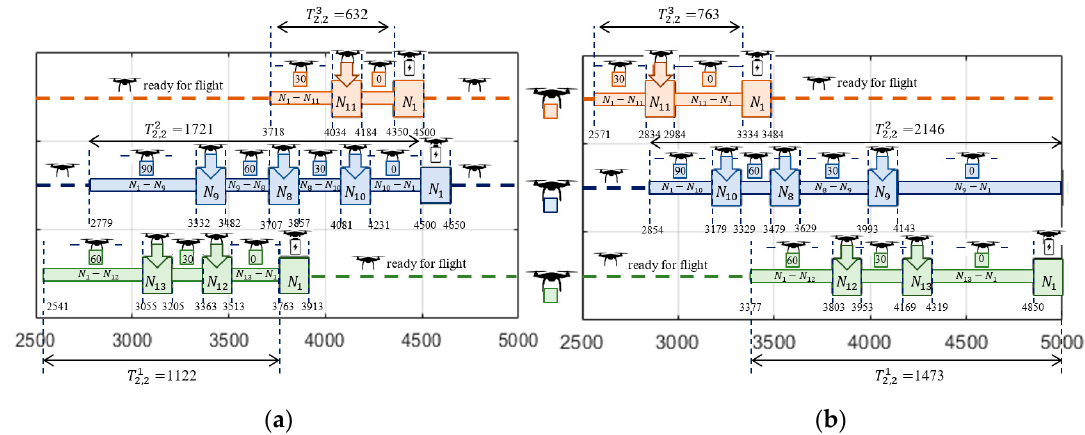
Figure 11. Obtained solution: ( a ) flight schedule for Strategy 1; ( b ) flight schedule for Strategy 2.